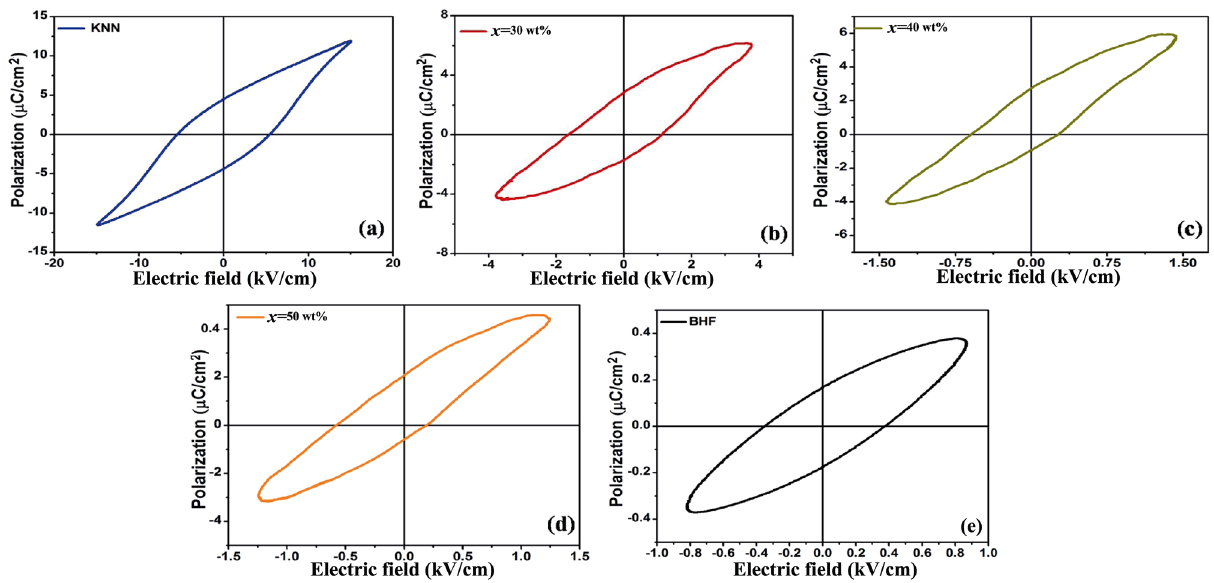
Fig. 8 P – E hysteresis loops for (1 ̶ x )KNN–( x )BHF composites obtained at room temperature: (a) KNN, (b) x = 30 wt%, (c) x = 40 wt%, and (d) x = 50